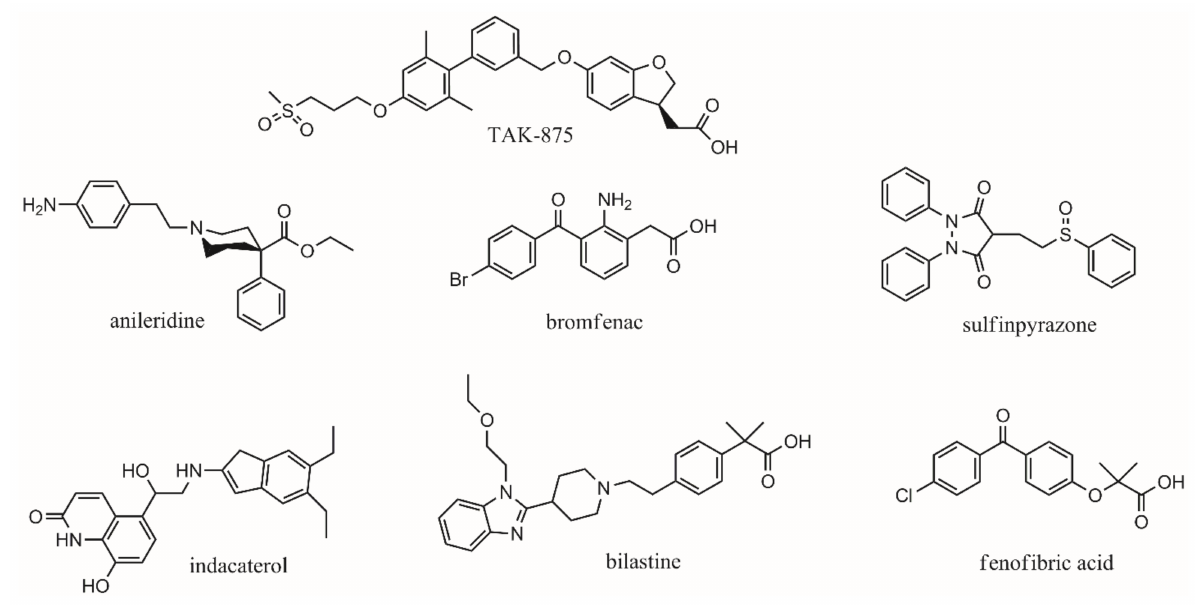
Figure 10. 2D structure of TAK-875 and the best compounds resulted from the